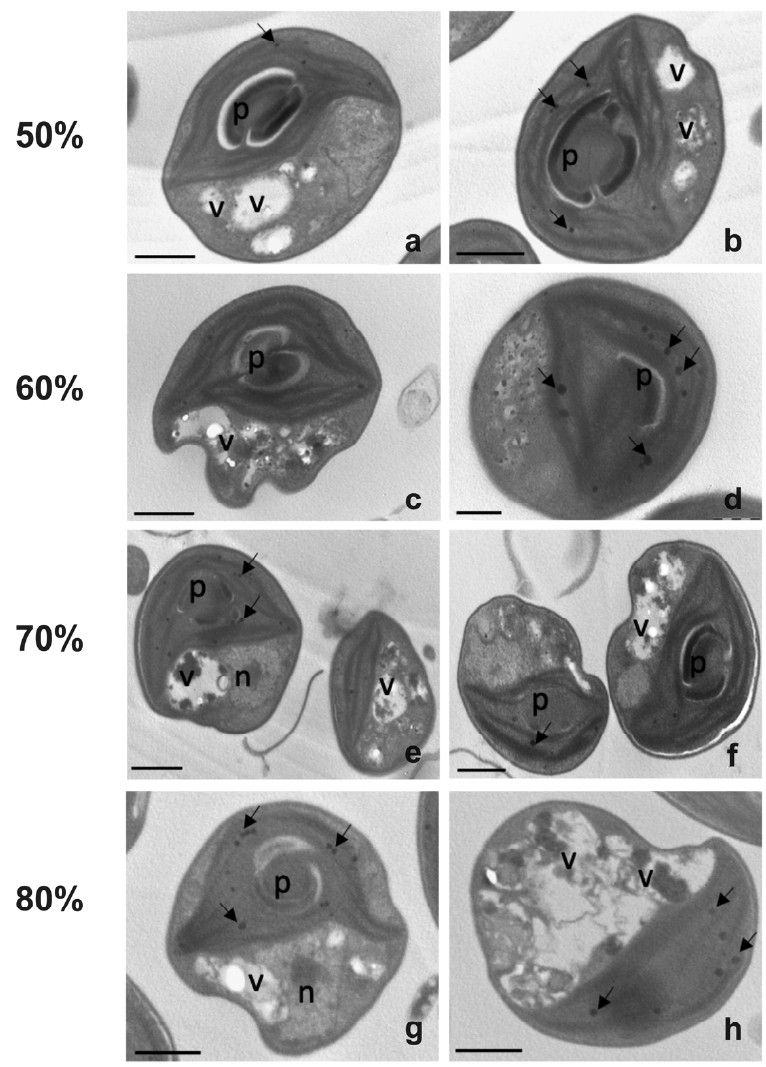
Figure 5. Transmission electron micrographs of Chlorella sp. cultivated in centrate stream diluted at 4 different concentrations: 50% ( a , b ), 60% ( c , d ), 70% ( e , f ), and 80% ( g , h ) of effluent. Pictures were taken at the end of cultivation (6 days). n, nucleus; p, pyrenoid; v, vacuolization; arrows, plastoglobules. Bars, ( a – c ), ( e – h ): 1 µm; d: 0.5 µm.